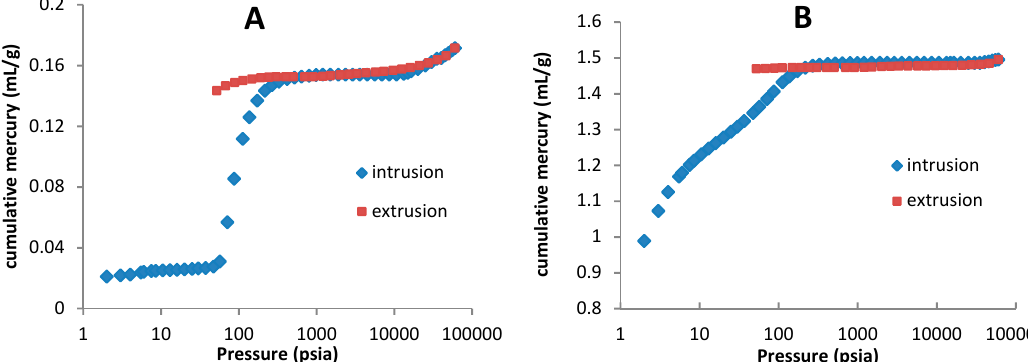
Figure 3. Mercury intrusion and extrusion curves from TPU tablets ( A ) and leached tablets ( B ).